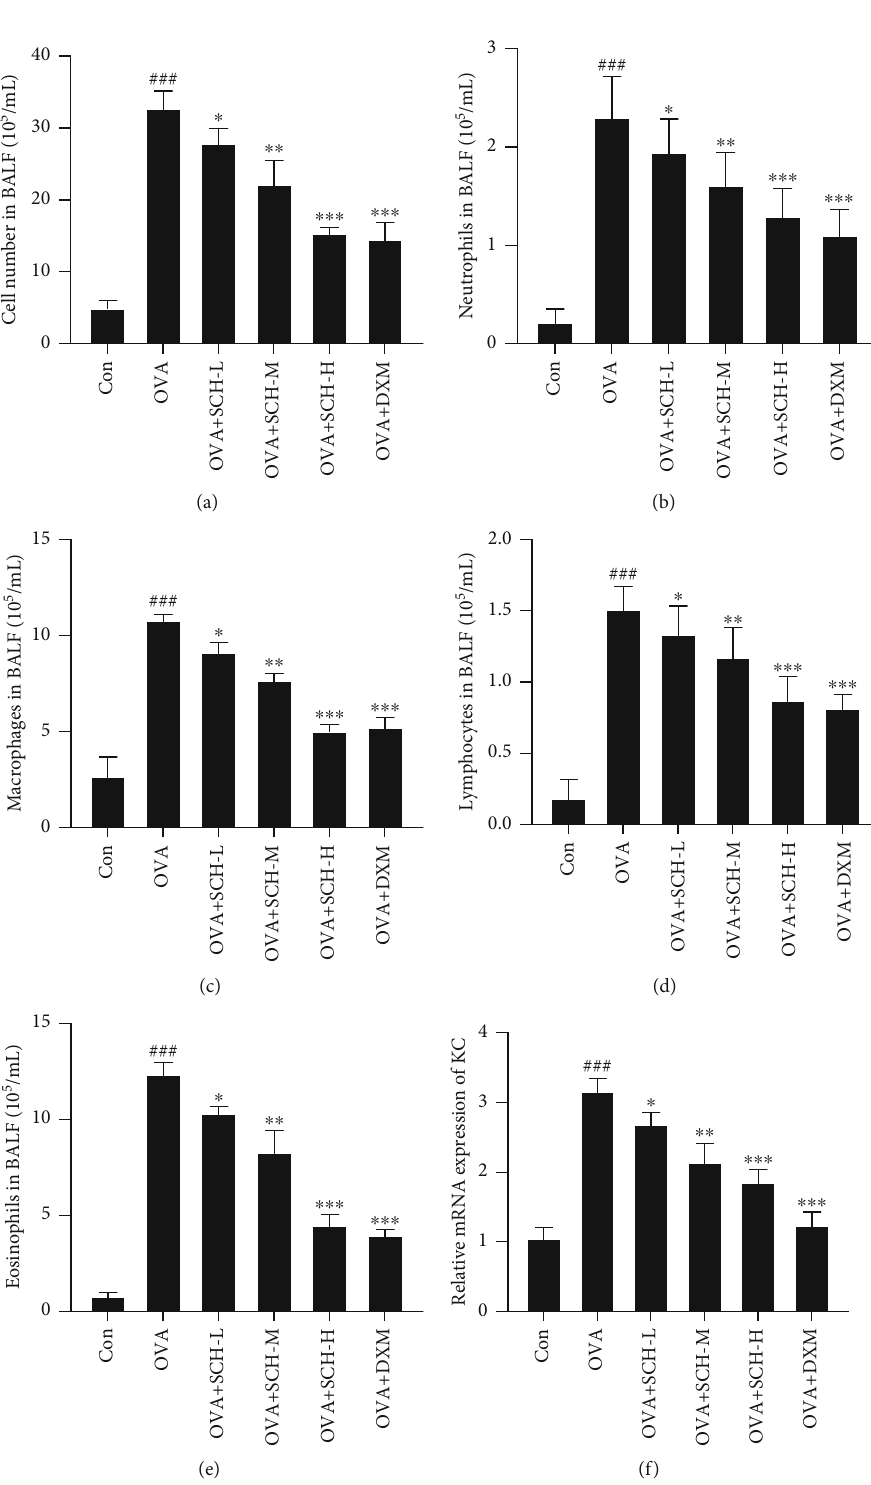
Figure 2: E ff ect of SCH on the number of in fl ammatory cells in BALF. The BALF was collected to determine the number of (a) total cells, (b) neutrophils, (c) lymphocytes, (d) macrophages, and (e) eosinophils and the (f) expression of the keratinocyte-derived protein chemokine (KC). Data are presented as the means ± SD ; n = 6 . ### p < 0 : 001 compared with the control group; ∗∗∗ p < 0 : 001 , ∗∗ p < 0 : 01 , and ∗ p < 0 : 05 compared with the OVA